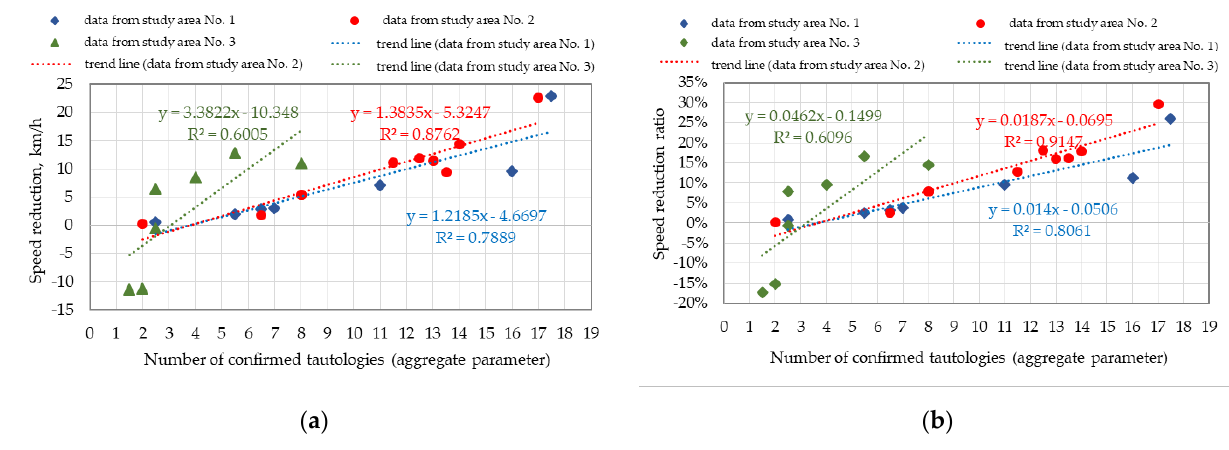
Figure 8. Relationship between speed reduction and SRR on the one hand and aggregate parameter on the other in three analysed study areas. (Data from study areas No. 1 and No. 2—based on the data given in [26,27]): ( a ) speed reduction ∆ v 85 ; ( b ) speed reduction ratio SRR. Source: own work of the authors.